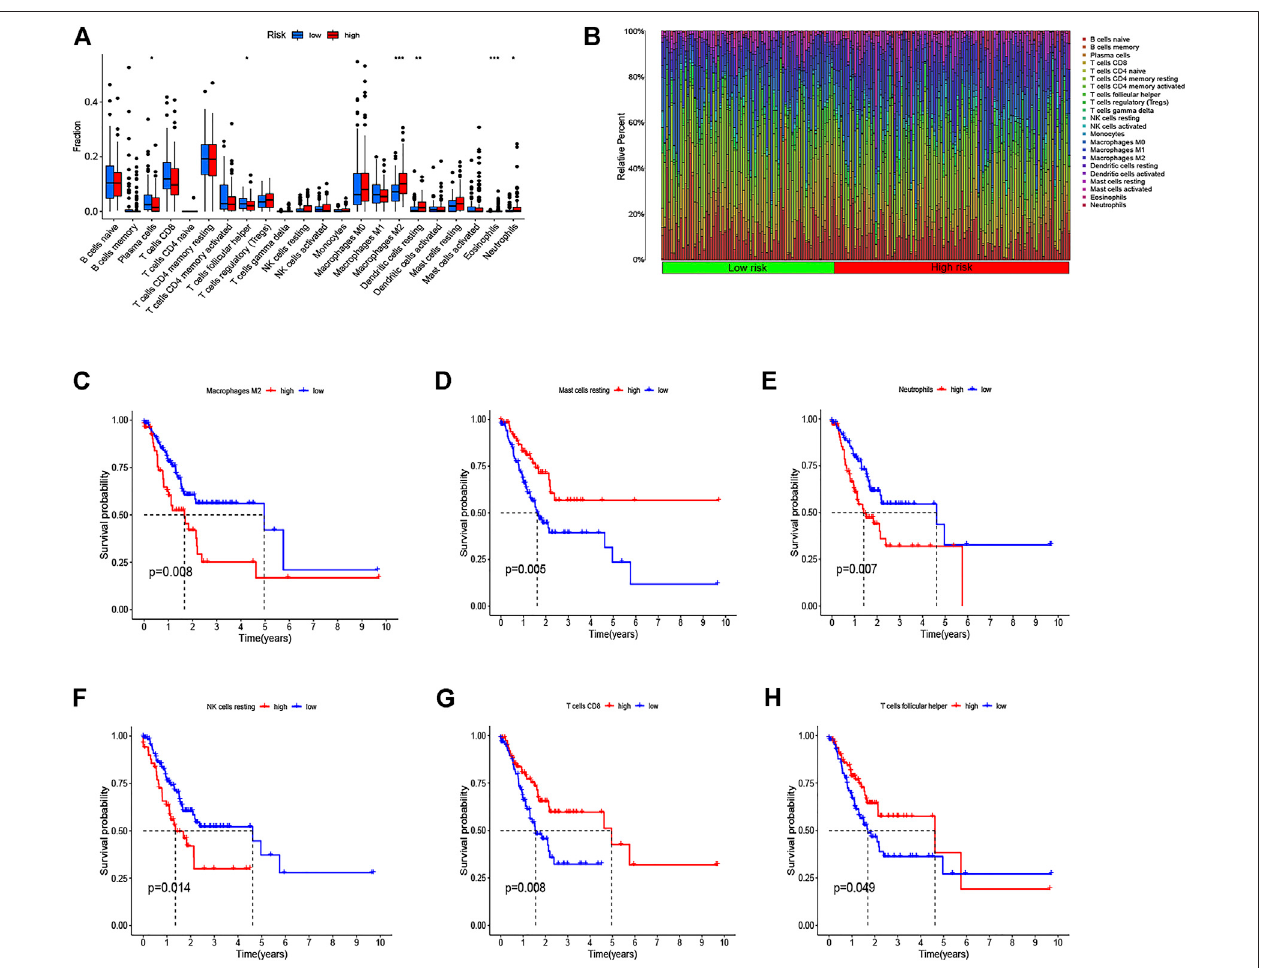
FIGURE8| Analysisofimmunecellin fi ltrationandtheKaplan – Meiercurveforsurvivalbasedonimmunecell. (A) In fi ltrationlevelofimmunecellsinthehigh-riskand low-risk groups. (B) Barplot shows the distribution of 22 immune cells in the high-risk and low-risk groups. (C – H) Kaplan – Meier survival curve shows the relationship between the six immune cells and survival with p <